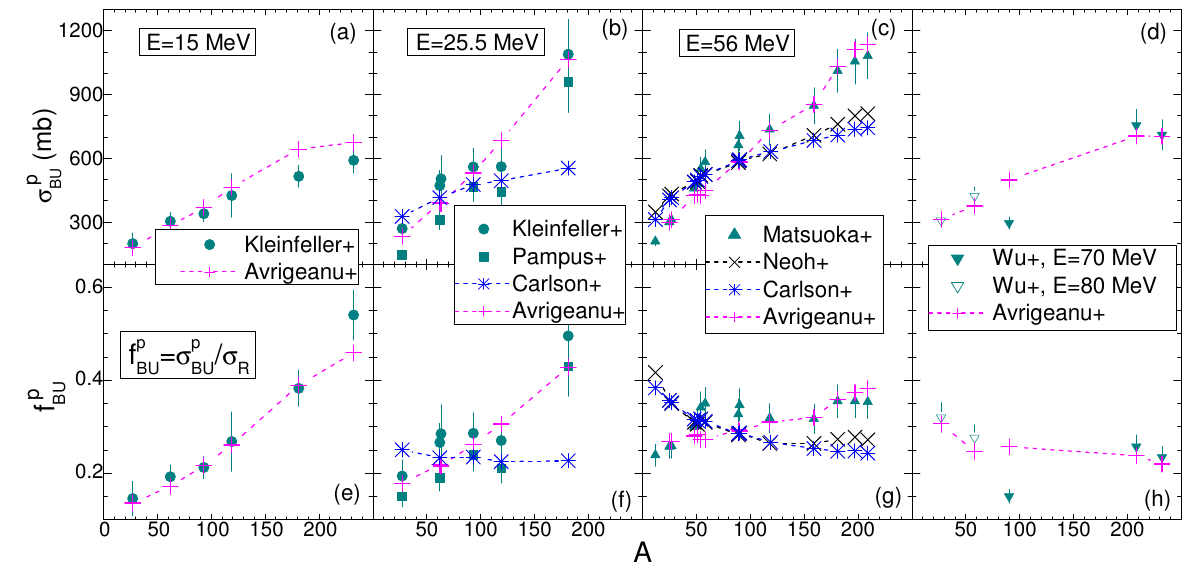
Figure 3. Comparison of the mass dependence of measured (solid circle, � , � , � , ▽ ) [13] total BU proton-emission cross sections (top) and fractions (bottom) with the predictions of the microscopic eikonal model [14] ( × ), DWBA formalism [15] ( ∗ ), and of the empirical parametrization ( + ) [12], connected by dashed lines for eye guiding, for target nuclei from 12 C up to 209 Bi, at the incident energies of 15, 25.5, 56, 70, and 80 MeV.